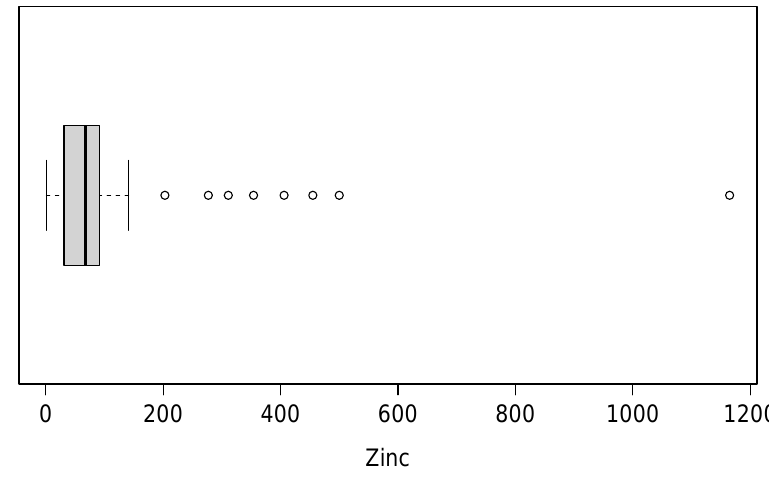
Figure 5. Boxplot for zinc dataset.